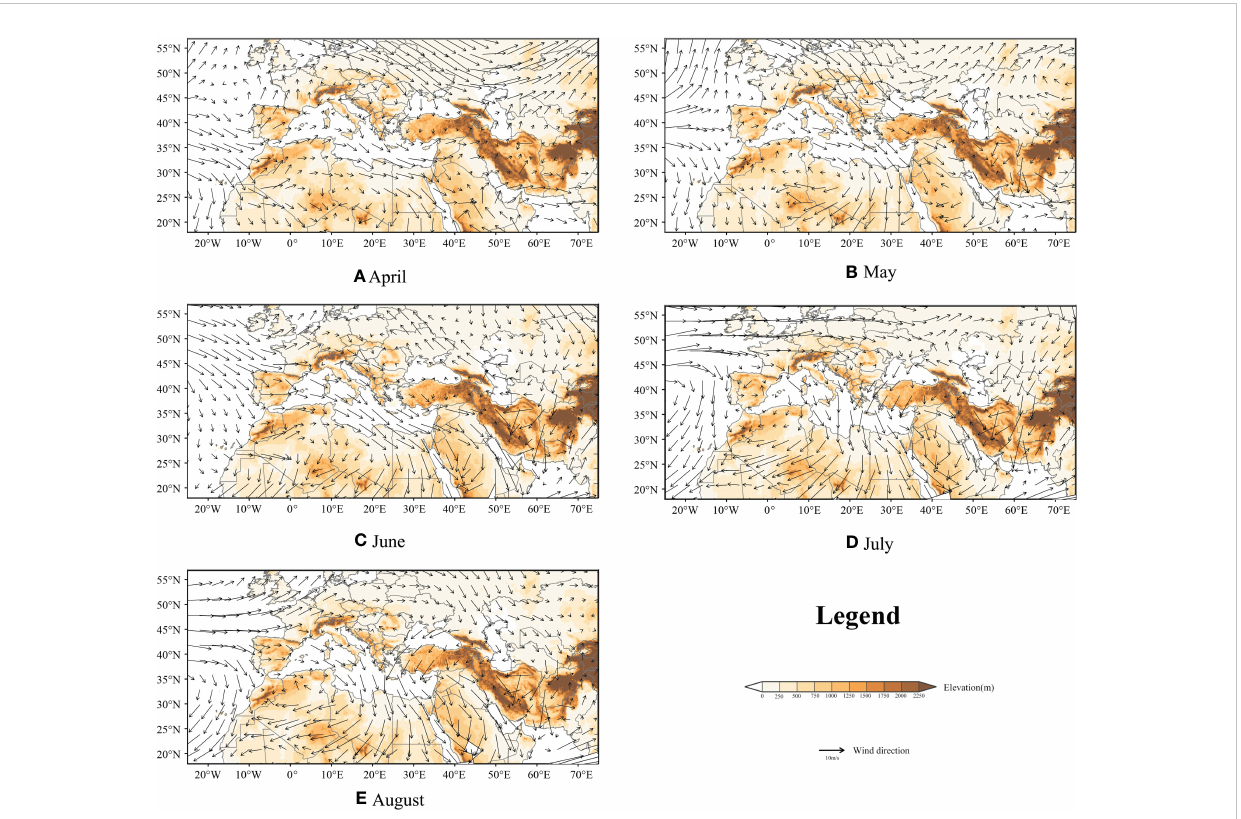
FIGURE 6 850hPa mean night atmospheric conditions from April to August; background represents topography; and arrows represent wind direction and speed; (A – E) : April to